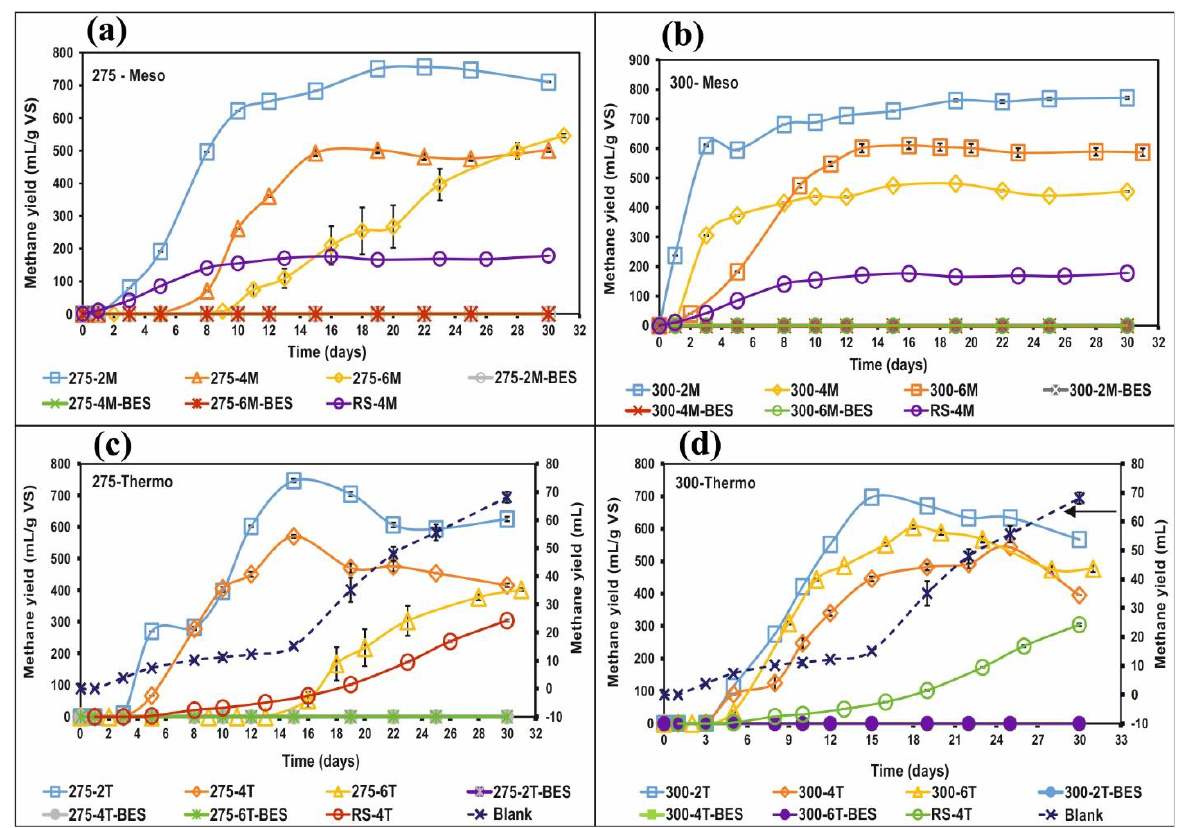
Figure 2. The cumulative methane yield at various substrate loadings for torrefaction condensate (TC) produced at 275 and 300 °C ( a , b ) mesophilic and ( c , d ) thermophilic conditions, respectively. The 2, 4, 6, represent substrate loadings (g VS/L); M and T represent mesophilic and thermophilic processes, respectively; RS represents raw sludge. For example, 275 − 2M − BES is for condensate produced at 275 °C, mesophilic conditions, 2 g VS/L loading and methanogenesis inhibition. The VFA yields for TC produced at different temperatures and at different